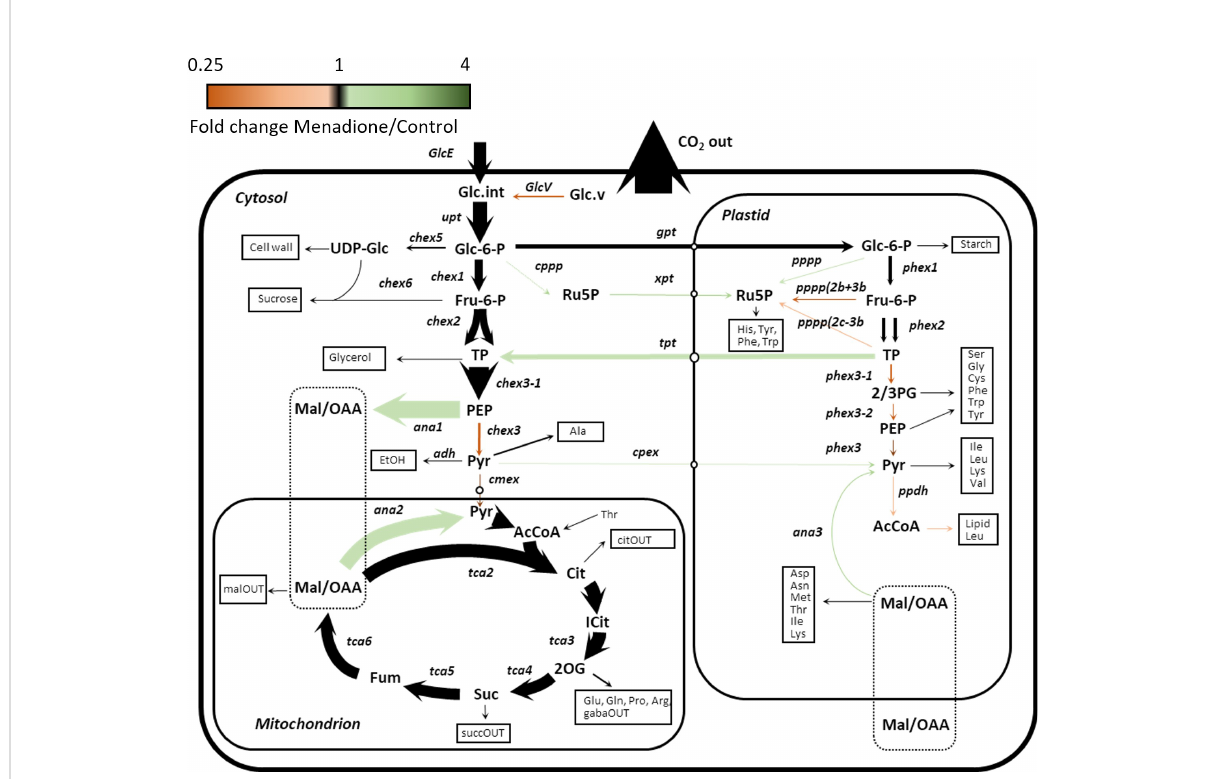
FIGURE 4 Flux map of central carbon metabolism in heterotrophic arabidopsis cell cultures treated with 60 µM menadione for 6 h or untreated control. Fluxes were deduced using INST-MFA following supply of [ 13 C 6 ]glucose. The arrow thickness is proportional to relative molar fl ux in menadione-treated cells. Arrow colour re fl ects the ratio of fl uxes between menadione-treated and control cells. Numerical values of all fl uxes are presented separately (Table 2, Supplementary